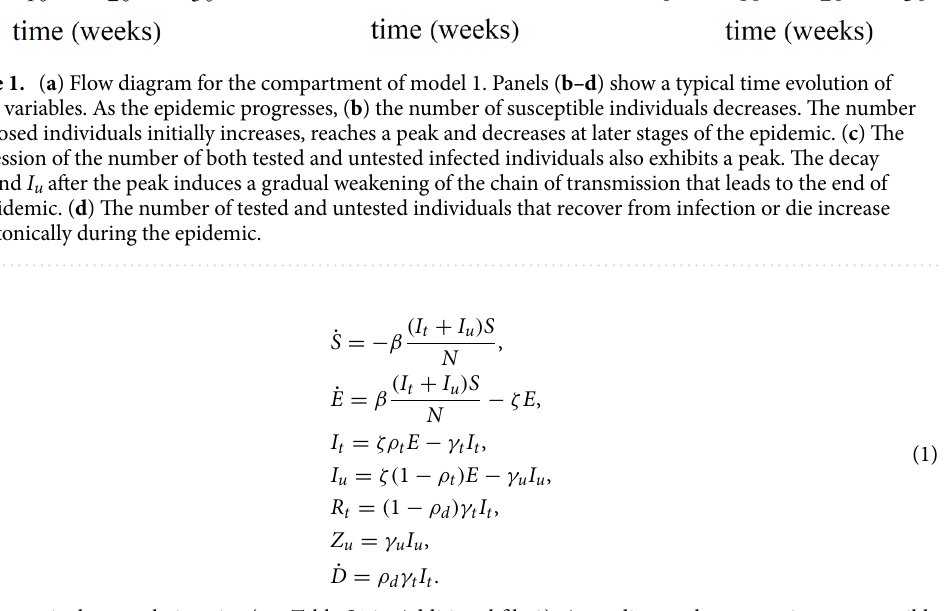
after which they become infectious. Of those that are infectious, a fraction ρ t are tested for infection and move